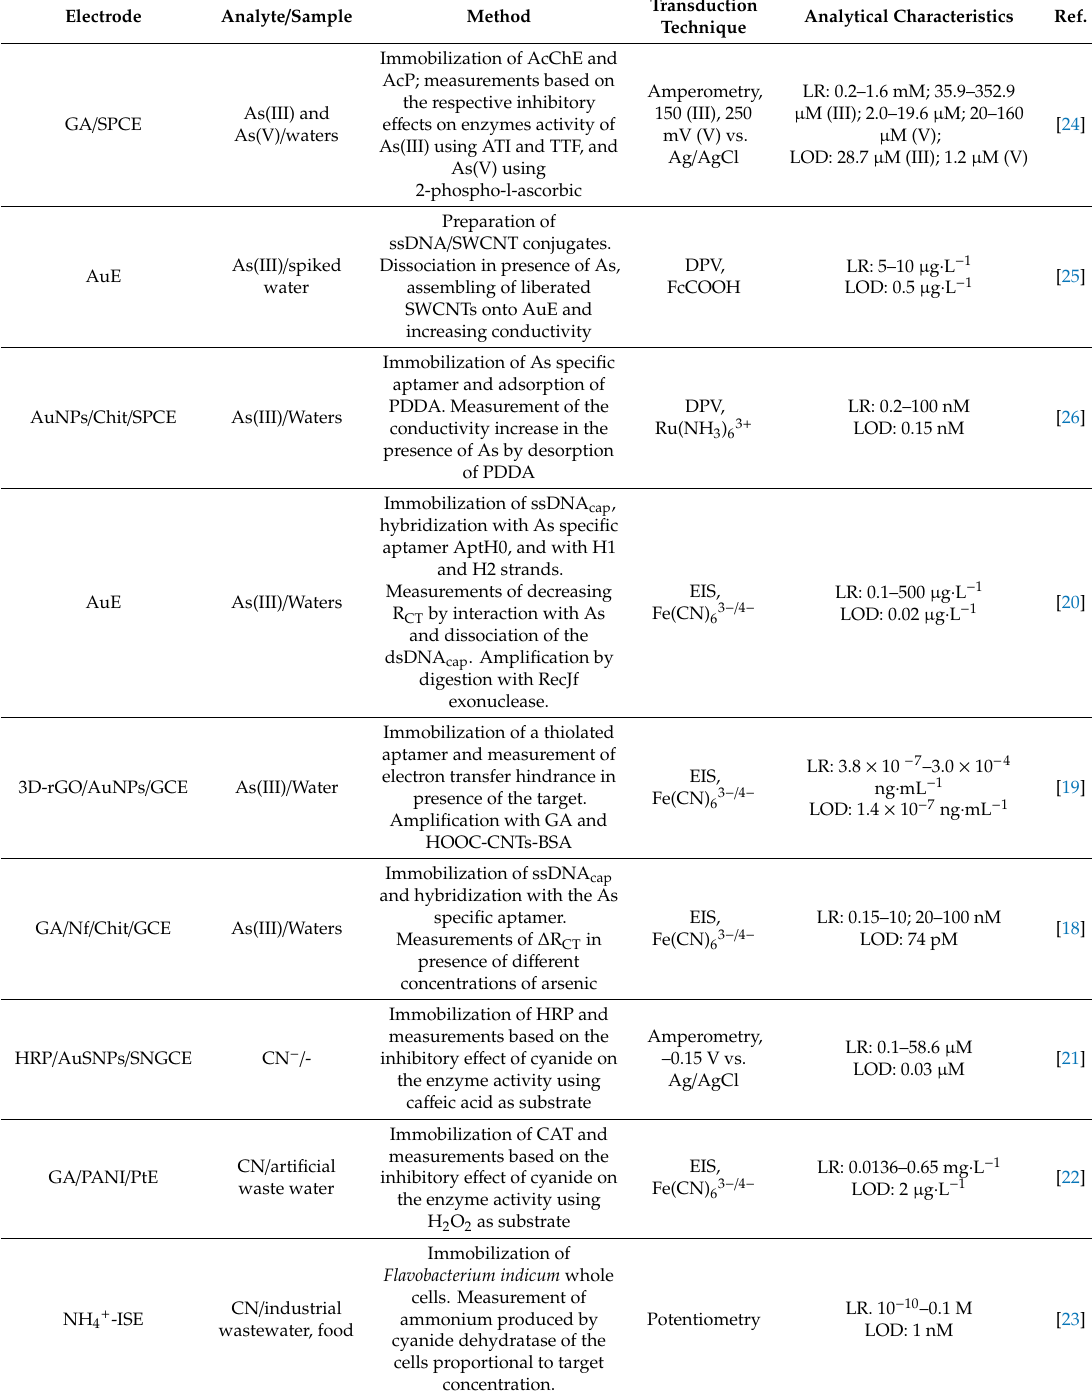
Table 1. Electrochemical biosensors for the determination of arsenic and cyanide. Electrode Analyte / Sample Method